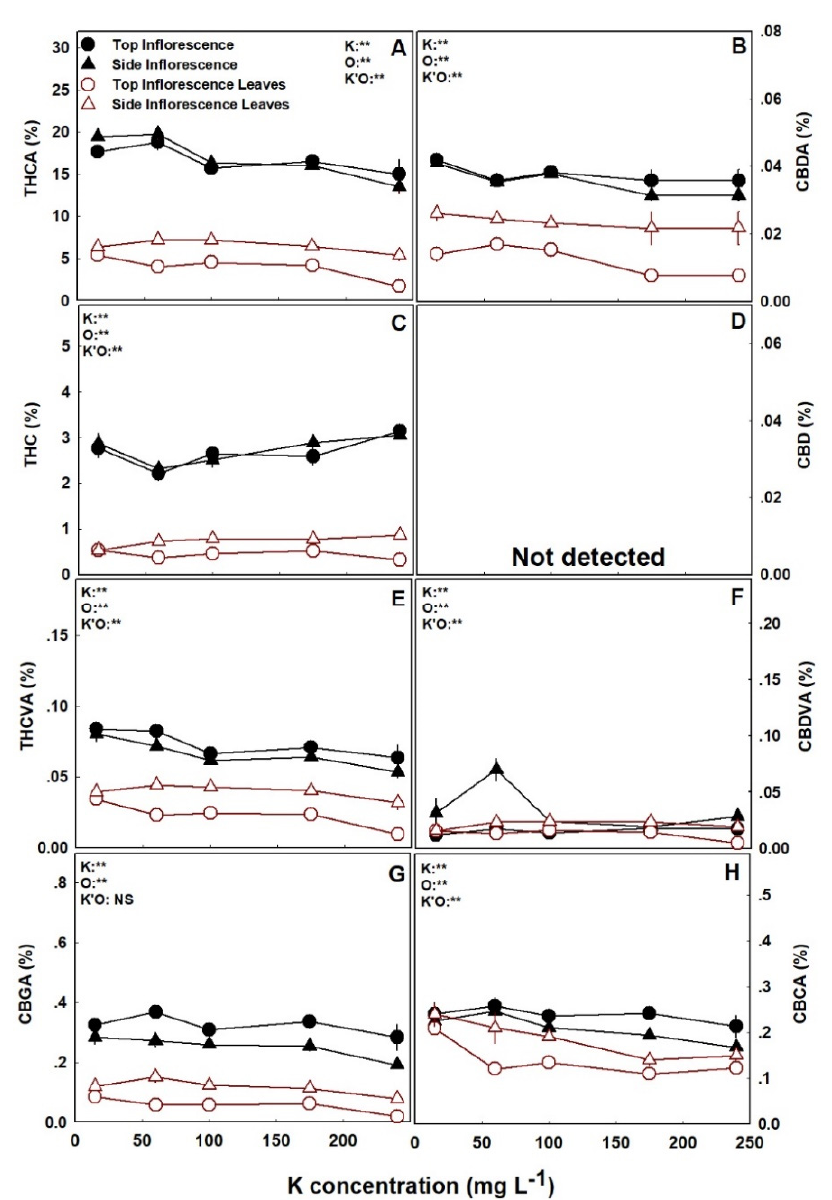
Figure 4. Effect of K supply on cannabinoid content in the medical cannabis cultivar DQ, at the top (primary) and side (secondary) inflorescences and inflorescence leaves. Presented data are averages ± SE ( n = 5). Where not seen, the error bars are smaller than the symbol size. Results of two-way ANOVA are indicated as ** p < 0.05, F -test; NS, not significant p > 0.05, F -test. In the ANOVA results, K ’ O represents the interaction between K and the plant organ. Results in units of mg g − 1 are presented in Figure S6 Supplemental.